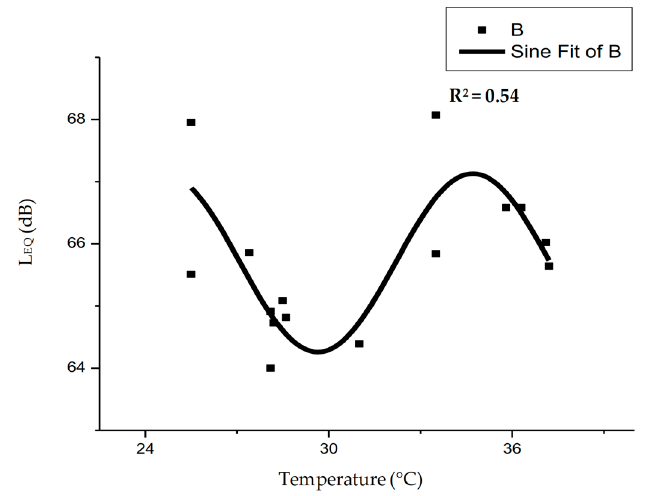
Figure 10. Correlation modeling between Temperature and Noise Level at OW-L.